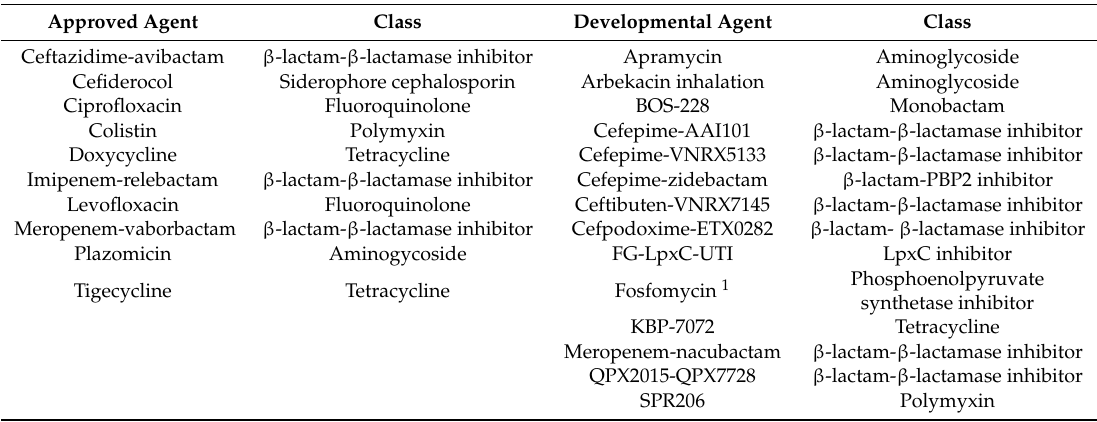
Table 1. Agents approved or in development active against